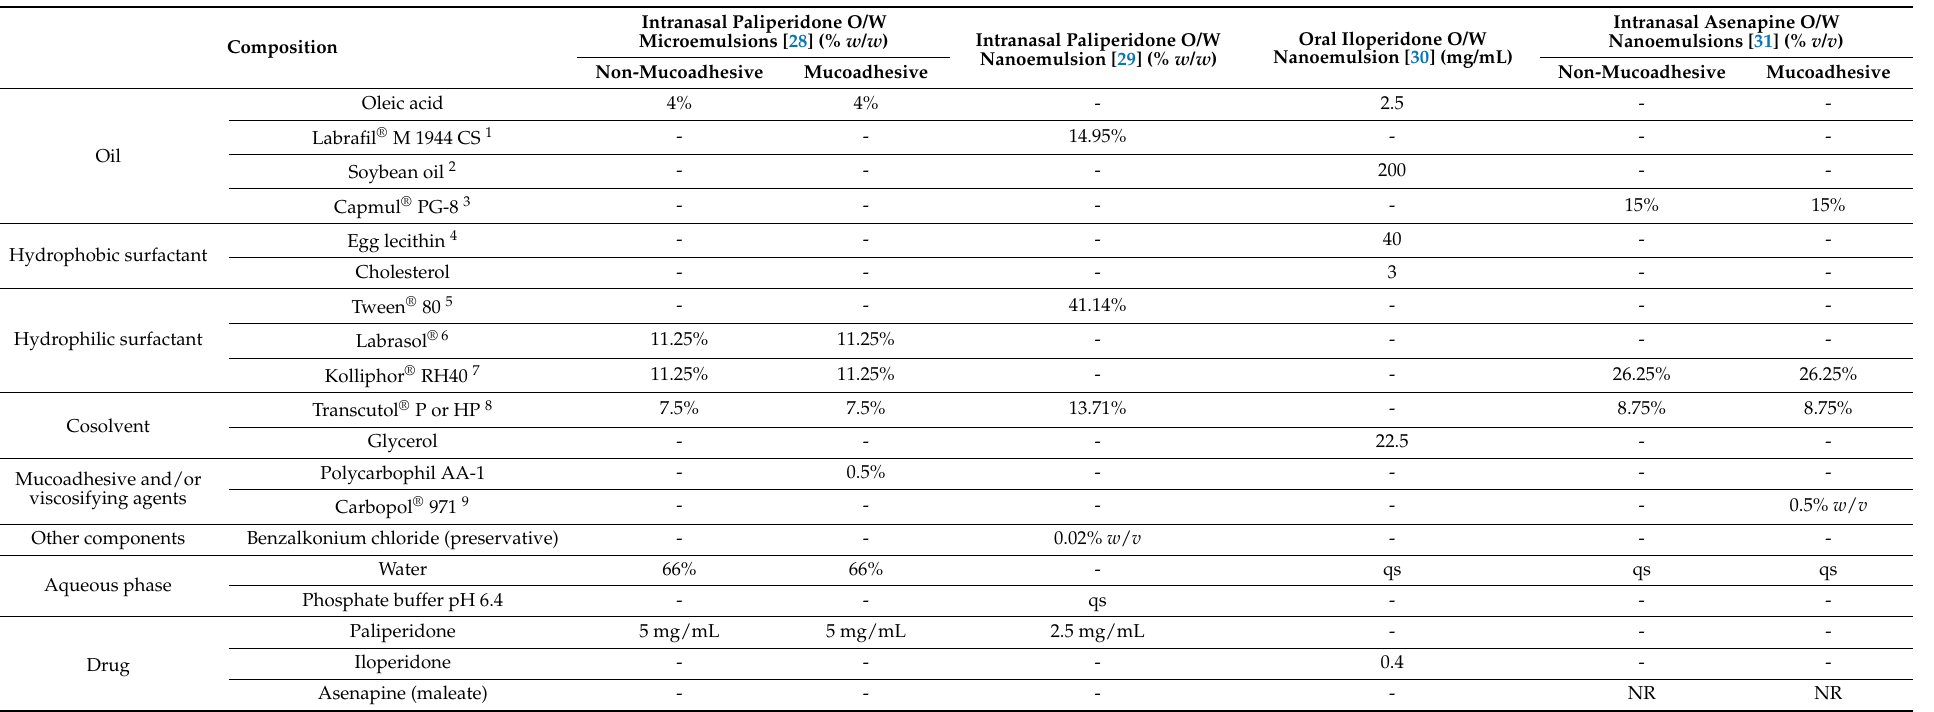
Table 6. Detailed composition of the intranasal paliperidone nano and microemulsions, oral iloperidone nanoemulsion and intranasal asenapine nanoemulsion. Excipient and drug quantities and units are shown as reported in the respective articles ( w / w %, v / v %, w / v % or mg/mL for excipients, and mg/mL for drugs). For the excipients the brand name was used (when